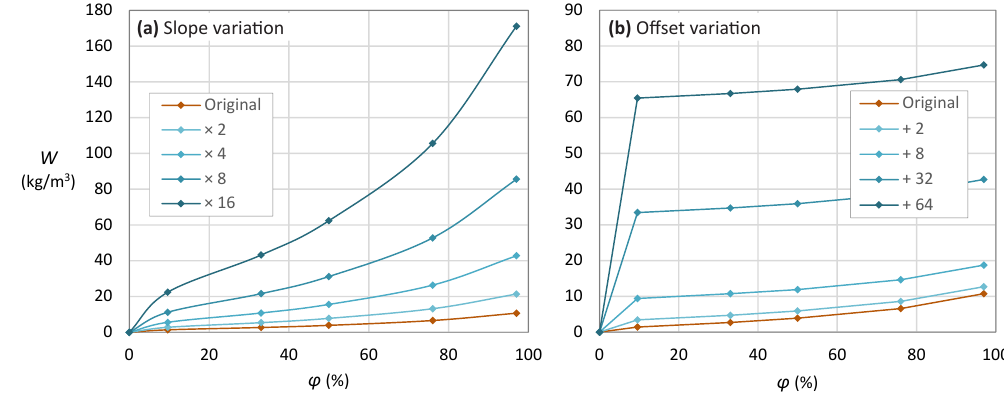
Figure 11. Variation of moisture retention curve ( a ) slope and ( b ) offset in unfired earth bricks, based on the original curve of Cagnon’s Unfired Earth Brick 1 [50]. Effects of these variations on intrinsic evaporative cooling performance are examined in Section 3.4.2 (Figures 12 and